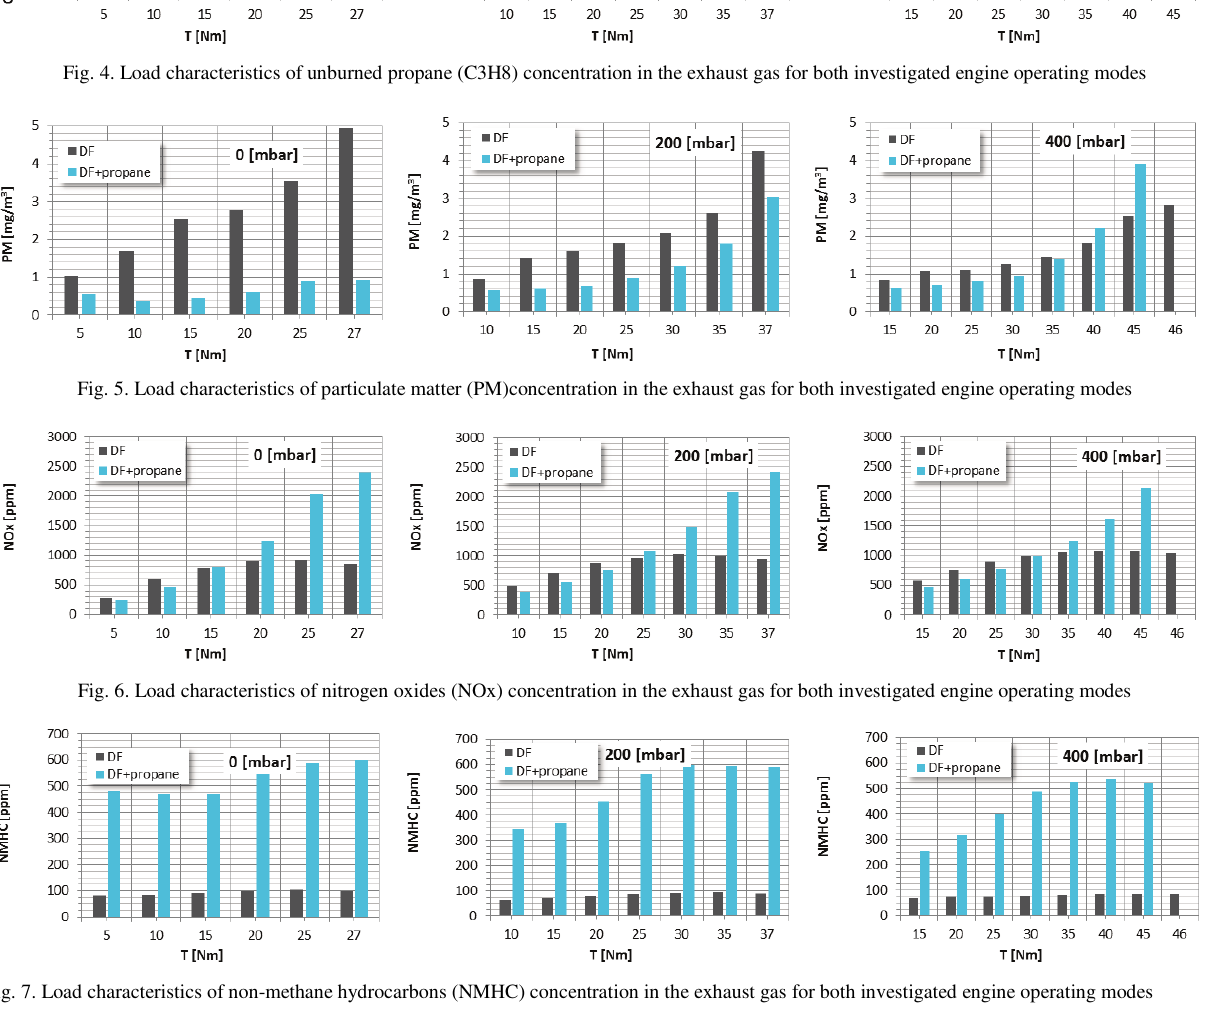
Fig. 7. Load characteristics of non-methane hydrocarbons (NMHC) concentration in the exhaust gas for both investigated engine operating